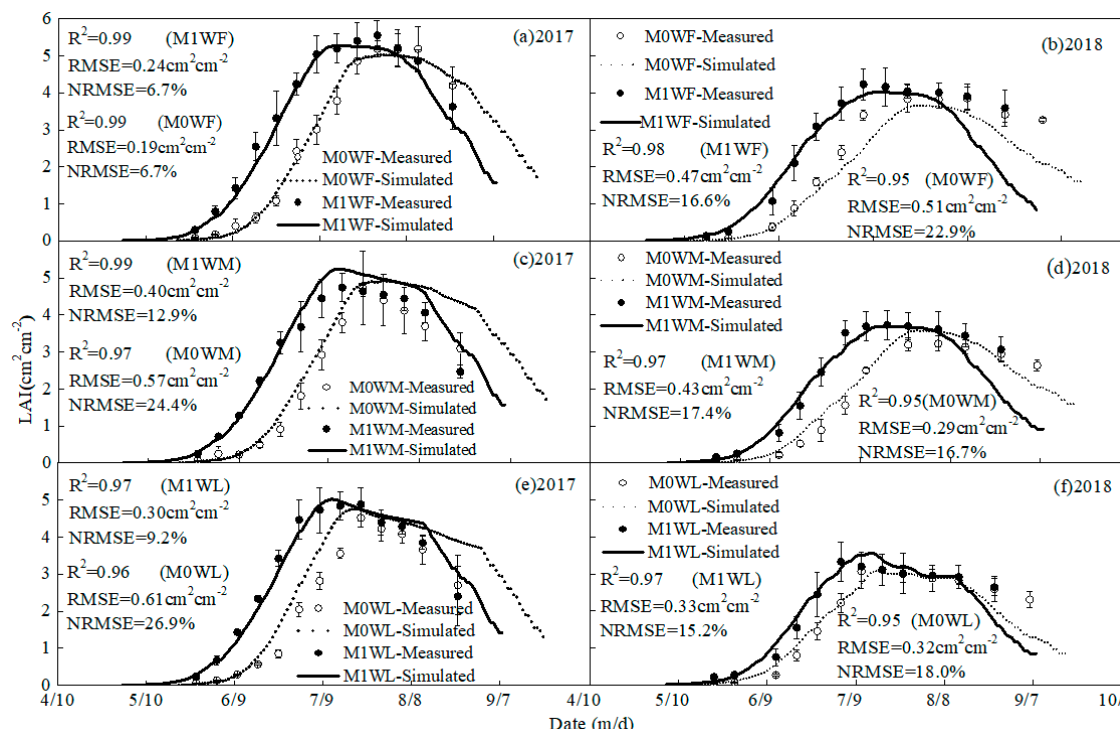
Figure 4. Comparison of the simulated and measured leaf area index (LAI) under different treatments during the entire growing season of 2017 ( a , c , e ) and 2018 ( b , d , f ). The average leaf senescence rate of measured LAI was 0.060 cm 2 cm − 2 day − 1 in 2017 and 0.015